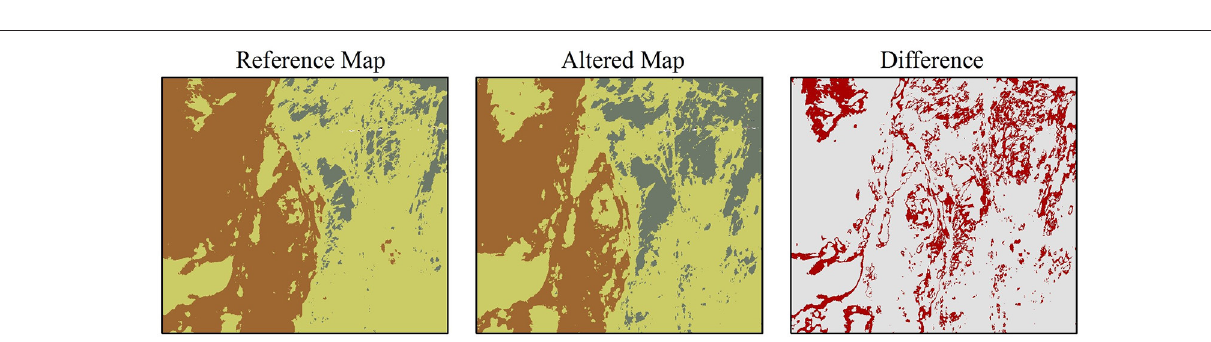
FIGURE 5 | Example of how replacing only one variable as input to the mapping process can produce different outcomes. The reference map is the same as in Figure 2 . The altered map was produced with all the same data layers, except that the slope data was replaced by rugosity data. The slope and rugosity layers are highly spatially correlated in this study area ( r =